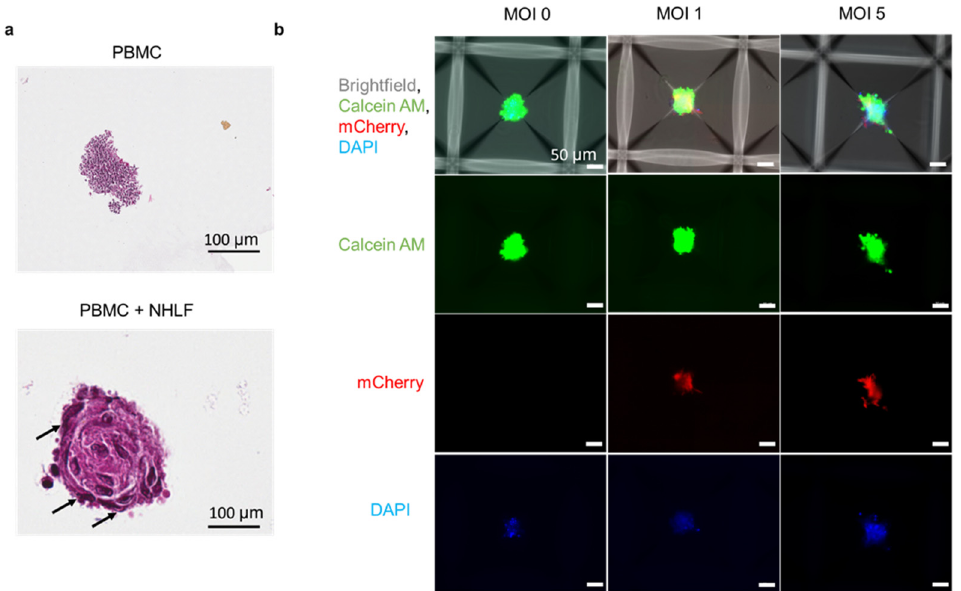
Figure 5. Formation of 3D co-culture spheroids ( a ) H&E-stained PBMC monoculture and NHLF co-cultured spheroids harvested on day 5 in culture. Arrows indicate fibroblast cells present in the periphery based on morphology. ( b ) Imaging live PBMC co-cultured spheroids with varying MOI of BCG mCherry using bright field, live (Calcein AM, Green) and dead (DAPI, blue) stain ( n = 2 wells/condition, ~1200 spheroids/well).